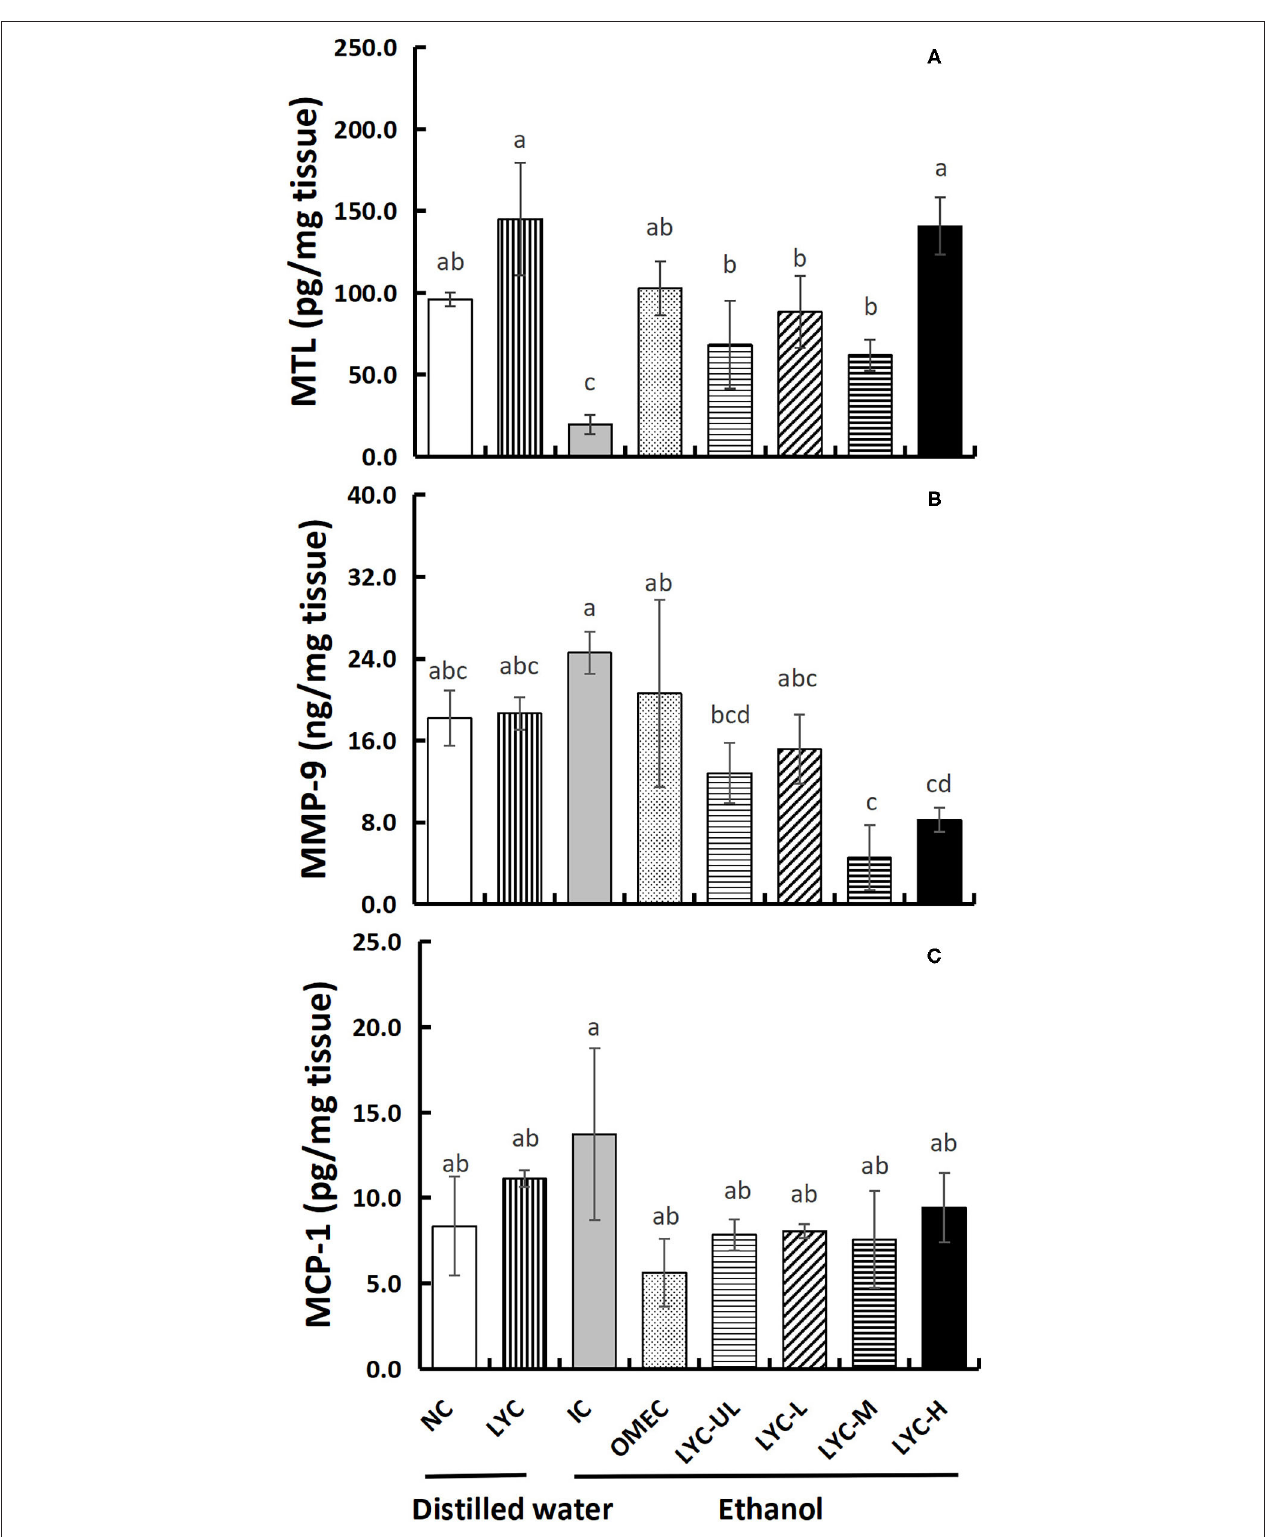
FIGURE 5 | Effect of lycopene on MTL, MMP-9, and MCP-1 levels of gastric tissues. NC, normal control group; LYC, lycopene control group; IC, injury control group; OMEC, omeprazole control group; LYC-UL, ultralow-dose group; LYC-L, lycopene low-dose group; LYC-M, lycopene medium-dose group; LYC-H, lycopene high dose group. (A) Motilin (MTL). (B) Matrix metalloproteinase-9 (MMP-9). (C) Monocyte chemoattractant protein-1 (MCP-1). Values are means standard deviation of 14 mice and triplicate measurements. Different letters indicate significant differences ( P < 0.05) between different groups.